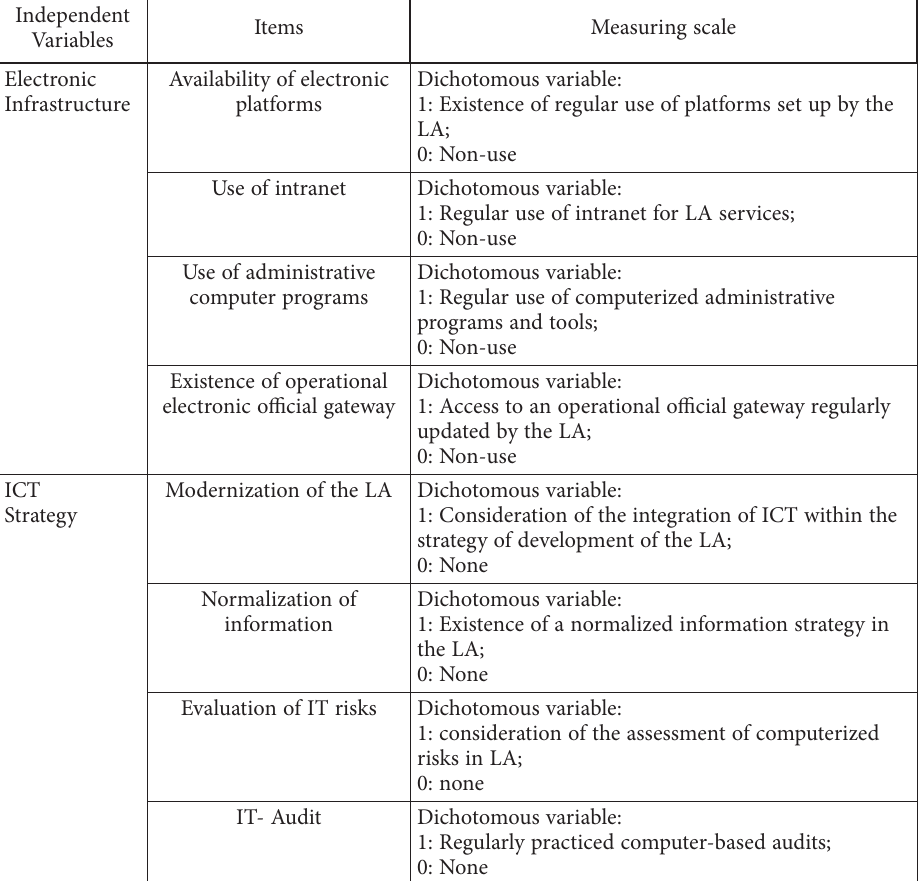
Table 1. Operationalization of independent variables (source: author’s conception) Independent